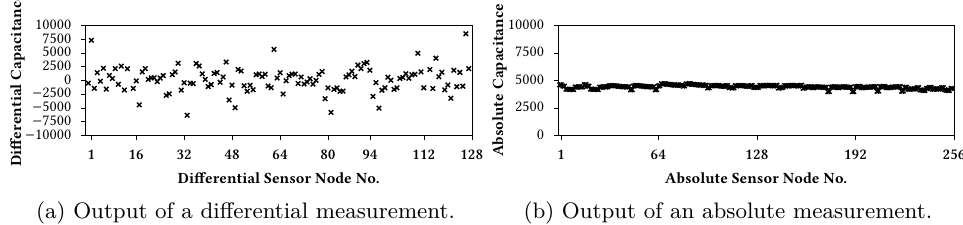
Figure 13: Exemplary measurement output of a single cover to illustrate basic properties of the system. 200 samples over time were averaged to create a noise-free